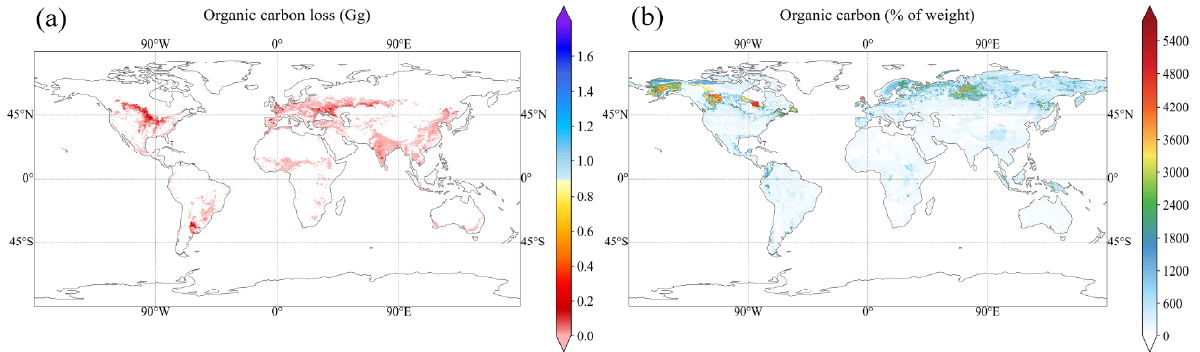
Figure 4. The spatial distribution of organic carbon loss from farmland and soil SOC concentration. ( a ) Global average loss of farmland organic carbon, 2017–2021; ( b ) percentage weight of organic carbon in the soil. These data are the percentage of organic carbon by weight in the soil surface layer (0–4.5 cm) multiplied by a correlation coefficient to obtain the final percentage value.